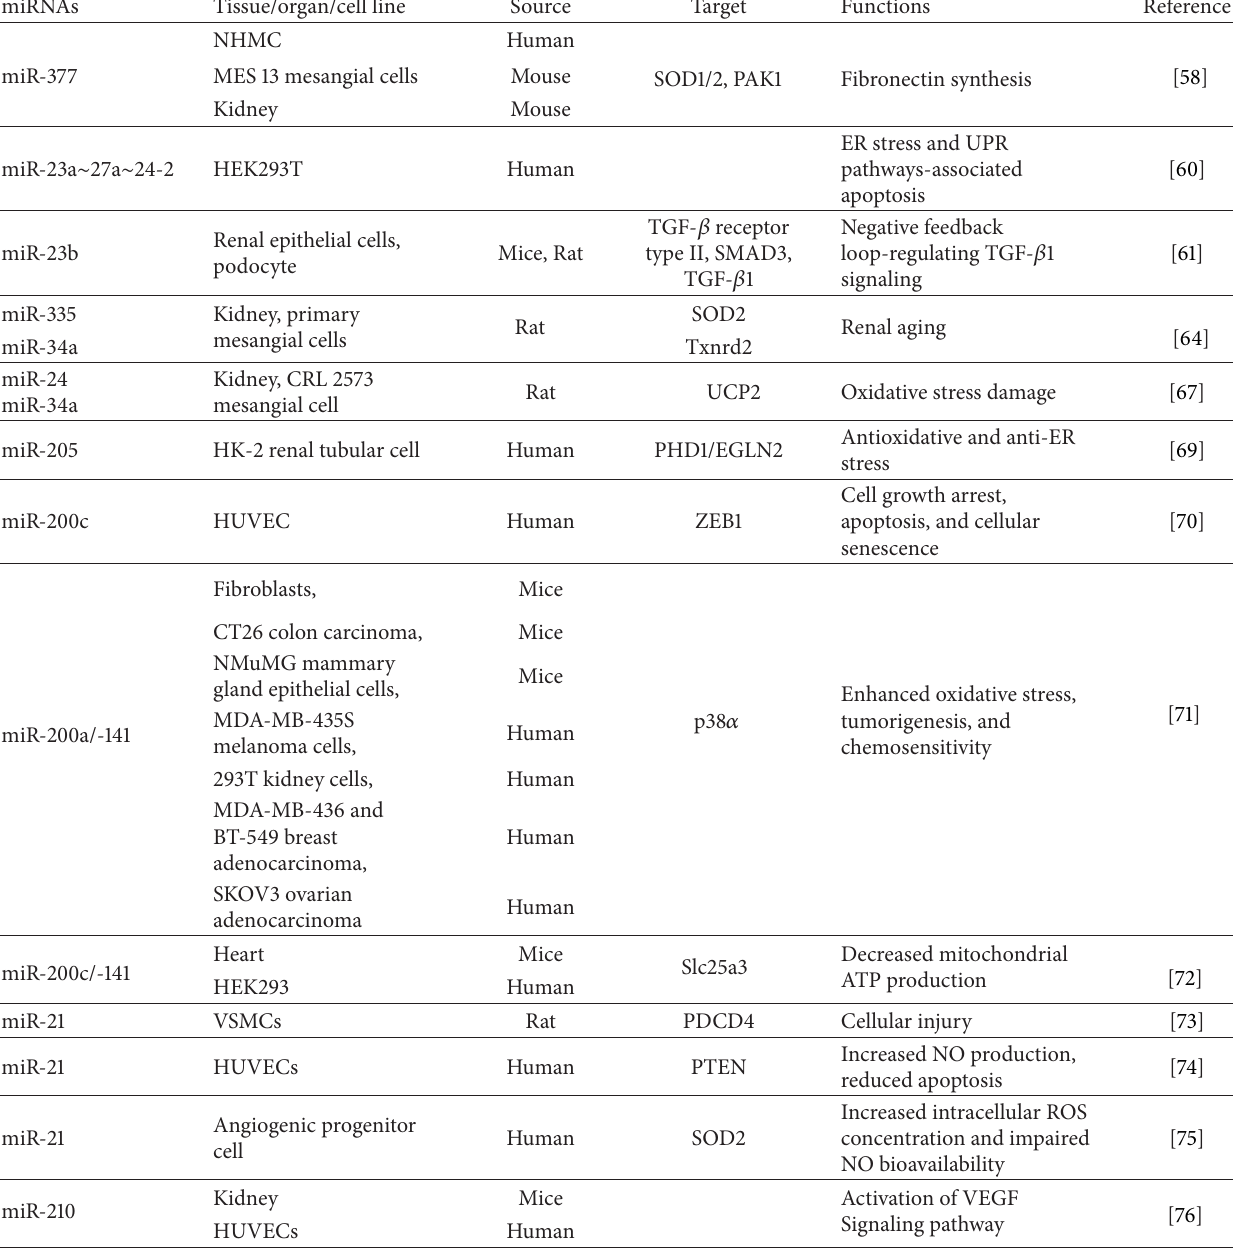
Table 3: Relevant miRNA in oxidative